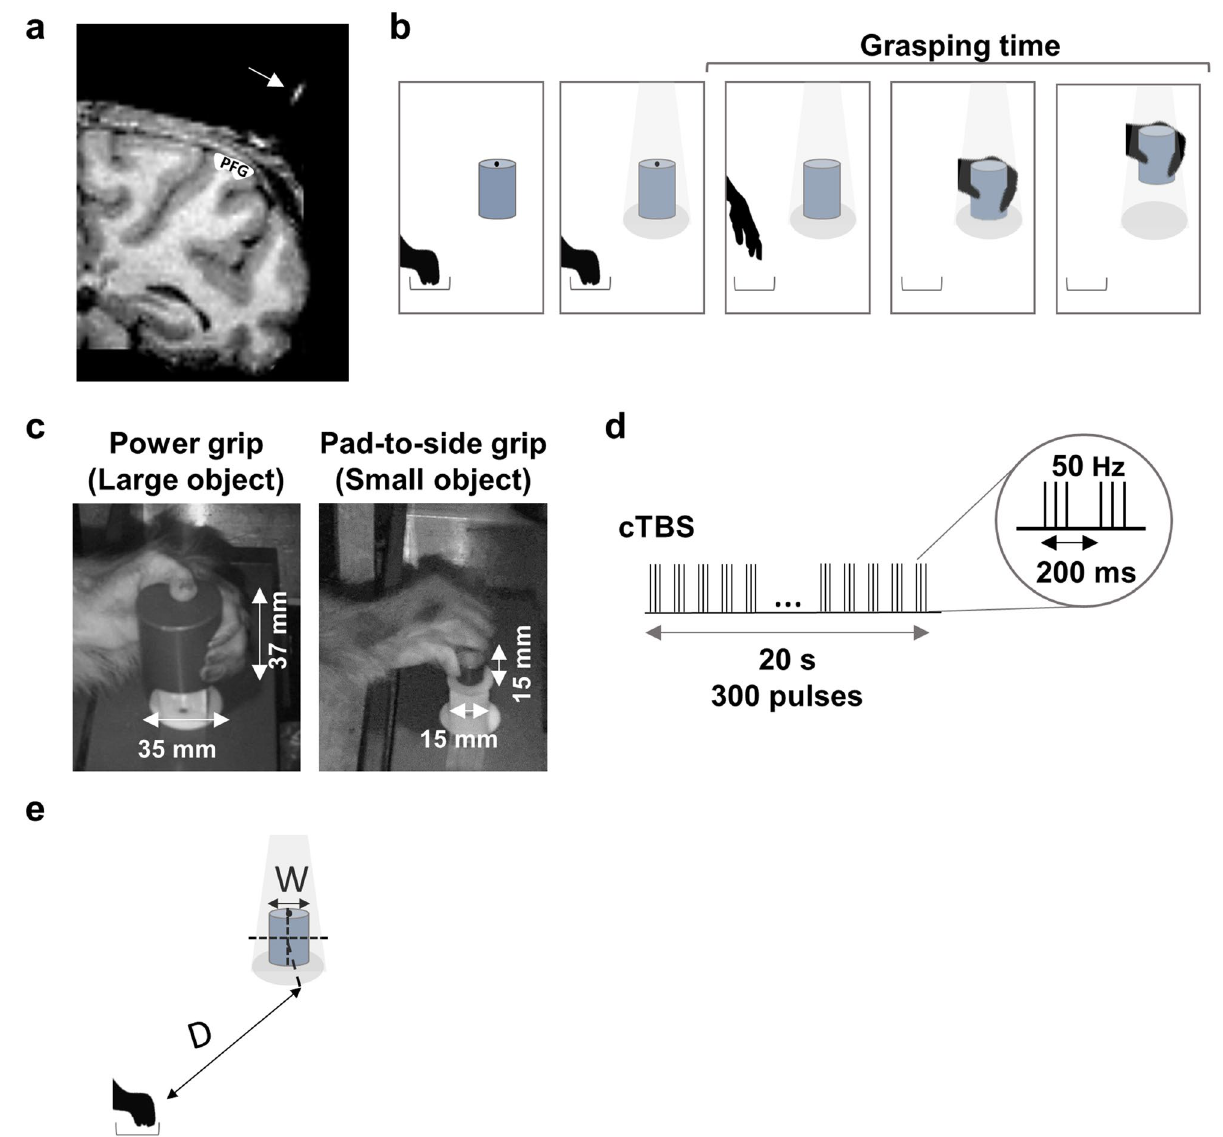
Figure 7. Experimental protocol. ( a ) Anatomical magnetic resonance image with the parietal area PFG indicated in white. The 25 mm figure-of-eight coil was positioned at a 45-degree angle with respect to the vertical. The white line (indicated by an arrow) represents the center of the TMS coil. ( b ) Visually-guided grasping task, which required the monkey to reach, grasp and lift an object after a go-signal (dimming of the red laser). ( c ) Grip types for the two cylindrical objects of different sizes used in the experiments. Grasping the large object (35 mm × 37 mm) elicited a power grip (whole-hand grasp), while the small object (15 mm × 15 mm) required a pad-to-side grip (involving exclusively the index finger and thumb). ( d ) Stimulation protocol. Our continuous Theta-Burst Stimulation (cTBS) protocol consisted of 50 Hz triplets of pulses applied every 200 ms. In total, 300 pulses were applied for 20 s. ( e ) Illustration of Fitts’ Law, stating that the time required to move to a target area is a function of the ratio between the distance to the target (D) and the width of the target